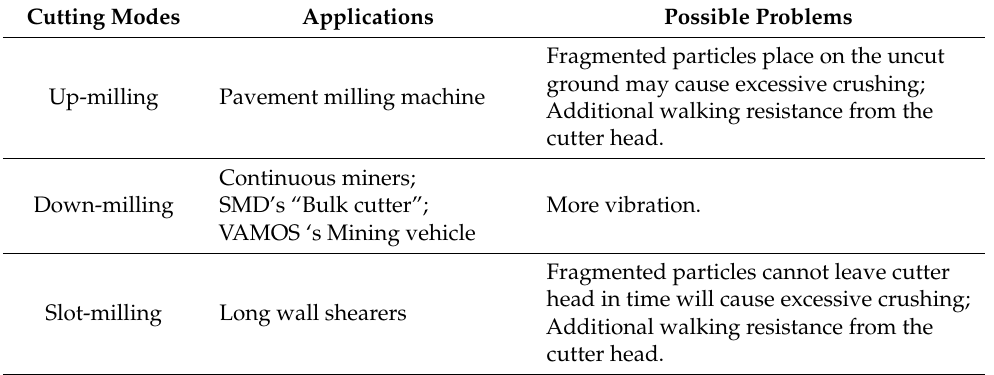
Table 4. Three cutting modes.